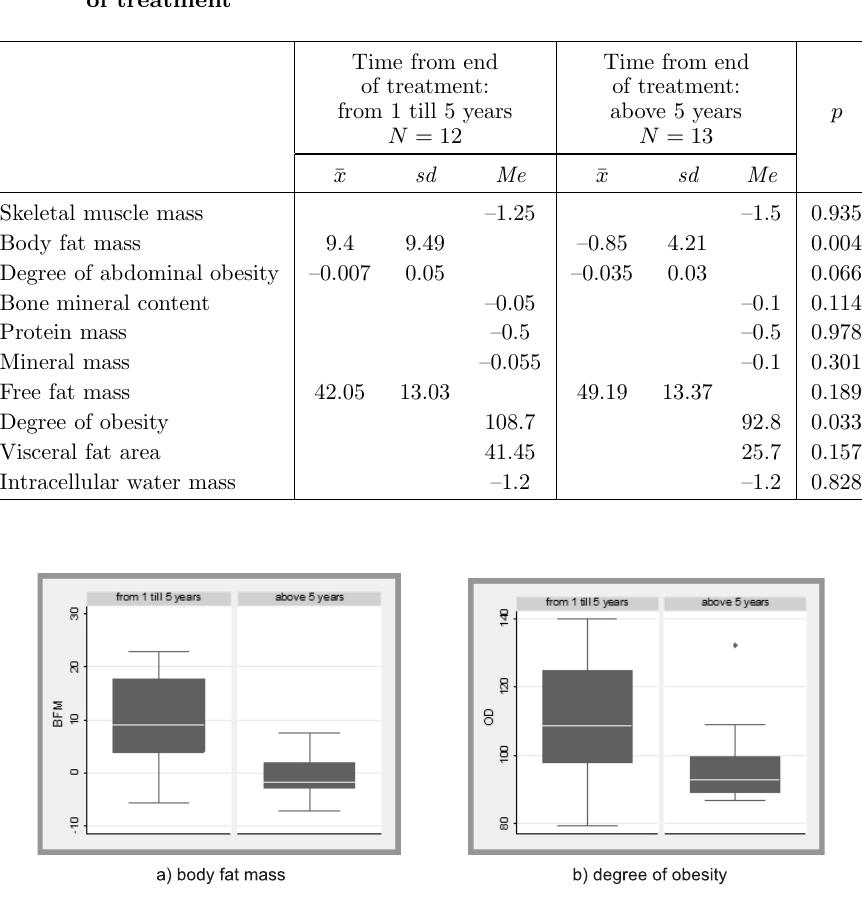
Table 6. Comparison of the parameters in groups related with time from end of treatment